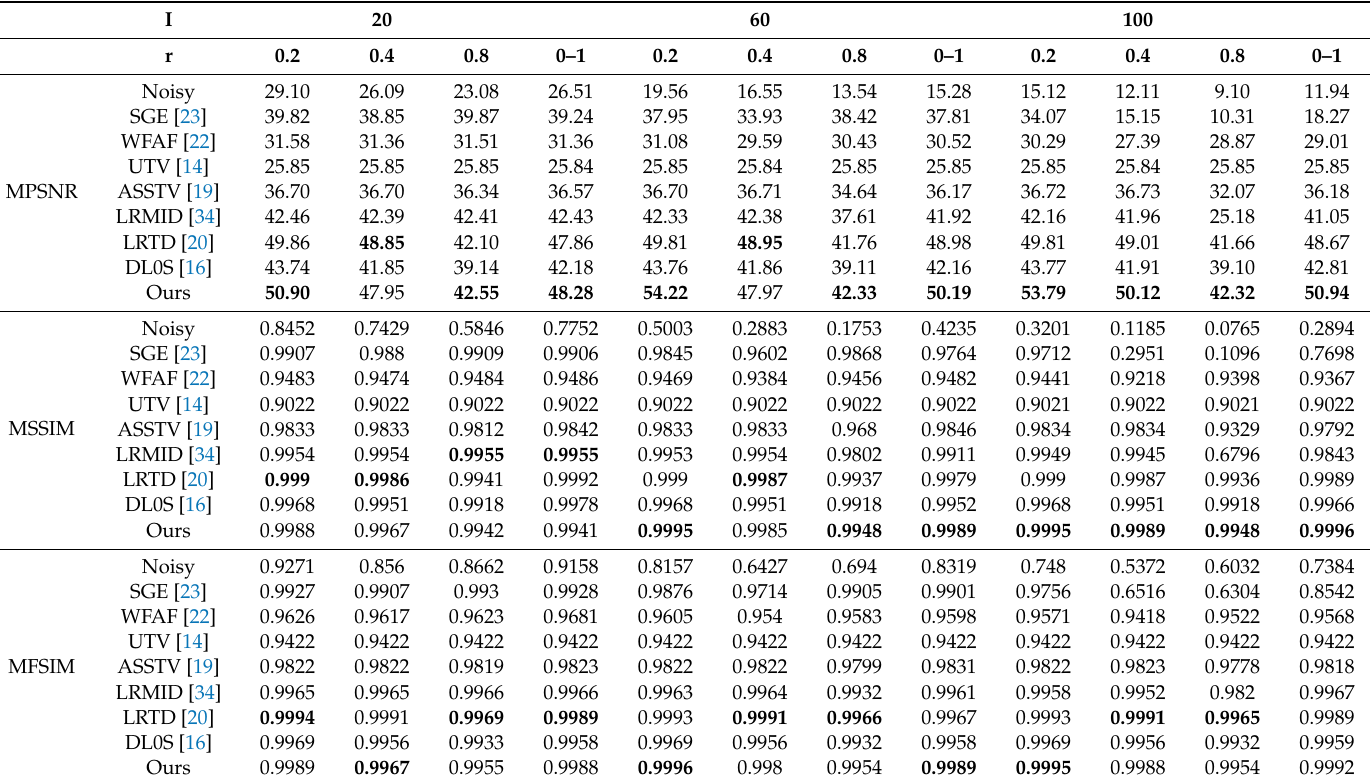
Table 1. The mean values of indices of WDCM with periodic